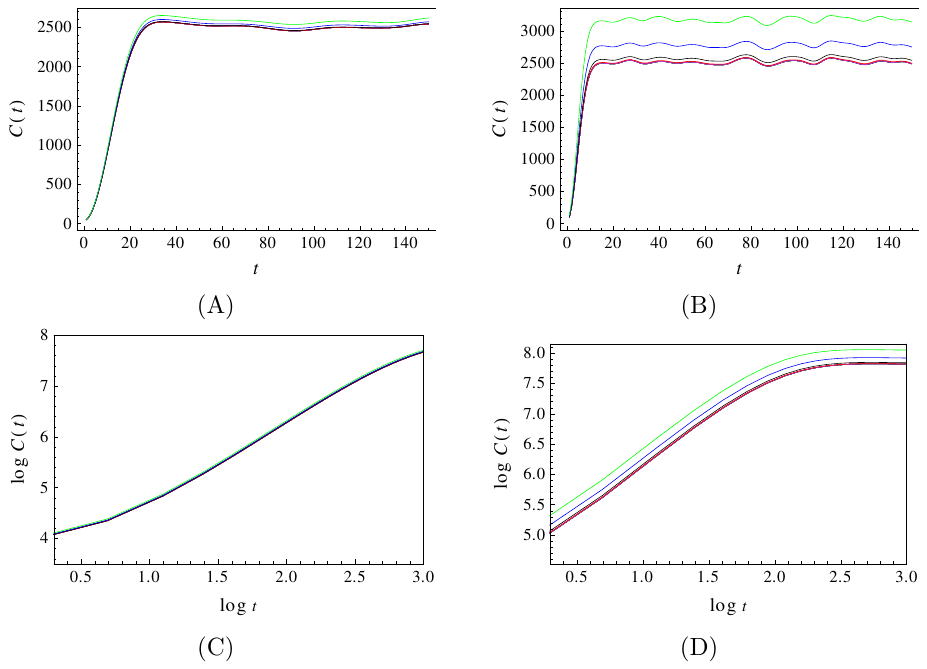
Figure 1. Numerically computed and averaged kinematic OTOC C ( t ) for an ensemble of l = 1000 Gaussian orthogonal matrices of size N = 20 for the deviation σ = 0 . 02 (A, C) and σ = 0 . 05 (B, D), at temperatures 0 . 67 (black), 1 . 00 (blue), 1 . 25 (green), 2 . 50 (magenta), 5 (red). The plots (A, B) show the linear scale and the plots (C, D) the log-log scale. Crucially, the growth regime is not exponential and is actually closer to a power law. The growth ends on a plateau with superimposed oscillations. The plateaus differ slightly for different temperatures — the main effect we look at in this paper. Times is in units 1 /σ in all